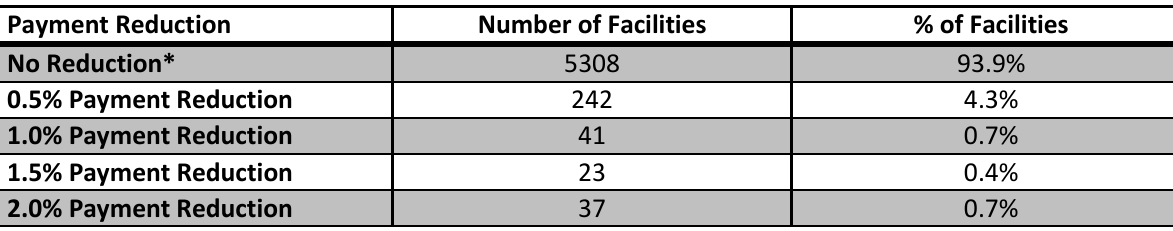
Table 11.7: PY 2015 ESRD QIP Payment